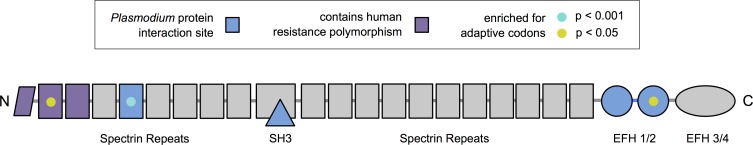
Domains of the alpha-spectrin (SPTA1) protein that interact biochemically with Plasmodium proteins are enriched for mammalian adaptation.Adaptation in each codon was determined with MEME on an 85-species alignment of SPTA1 coding sequence (Methods, Alpha-spectrin). Plasmodium interaction sites, and sites of human resistance mutations, were drawn from the literature (see text).